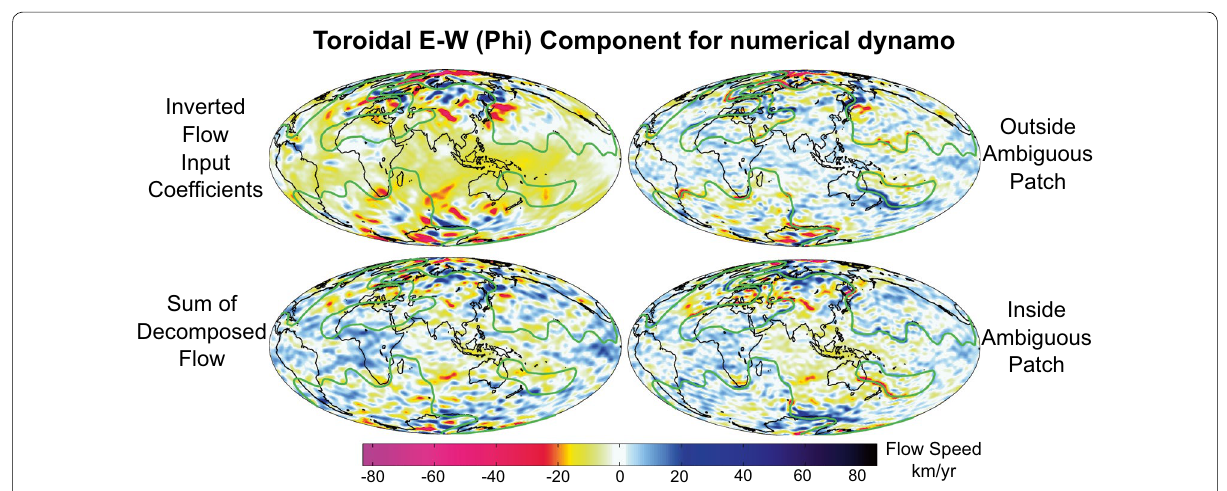
Fig. 10 Decomposition of numerical dynamo simulation only using coefficients that are larger than the input value. Flow maps of the decomposition shown in Fig. 7 when only the absolute value of each coefficients that are bigger than the input coefficients is plotted. There is no longer a distinction between inside and outside the region of interest, and the flow is concentrated in strong bands along the boundaries of the regions. The φ -component of the toroidal flow is